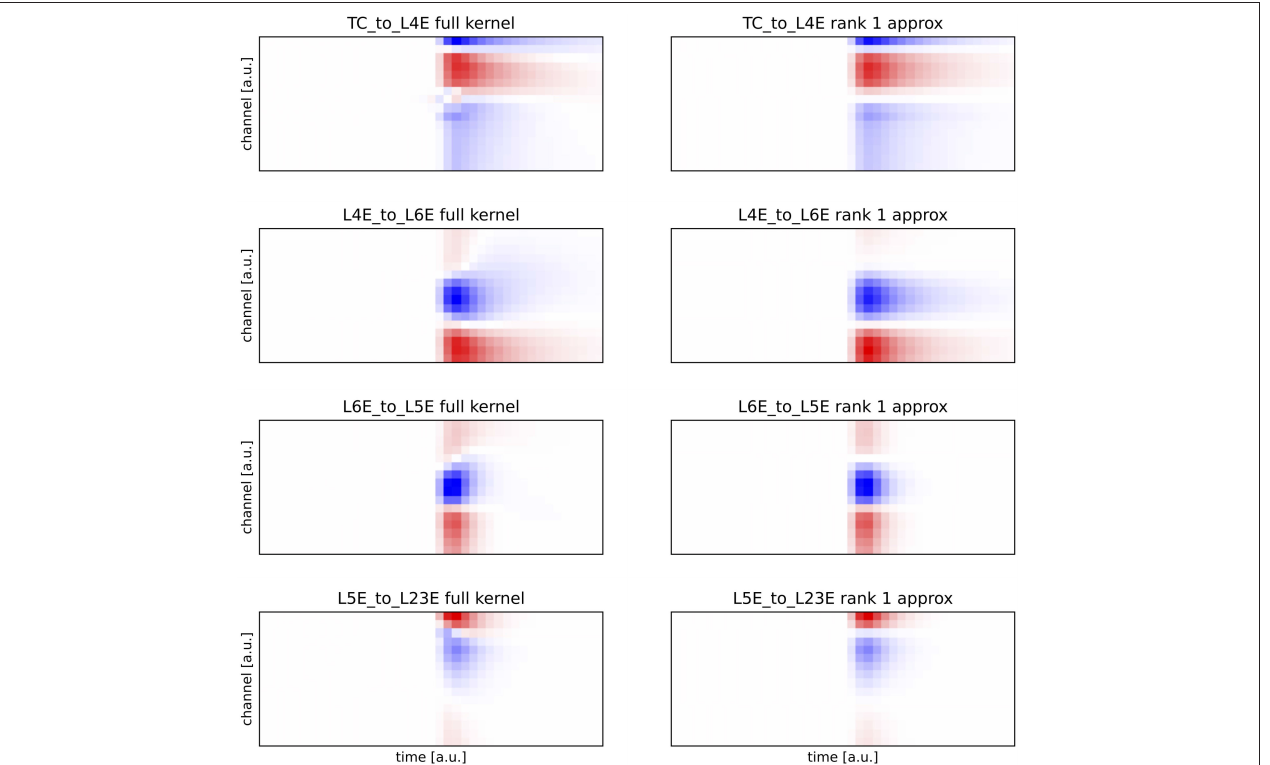
FIGURE A1 | Comparison of the full kernels (left side) and their rank 1 approximation (right side). Plots have equal